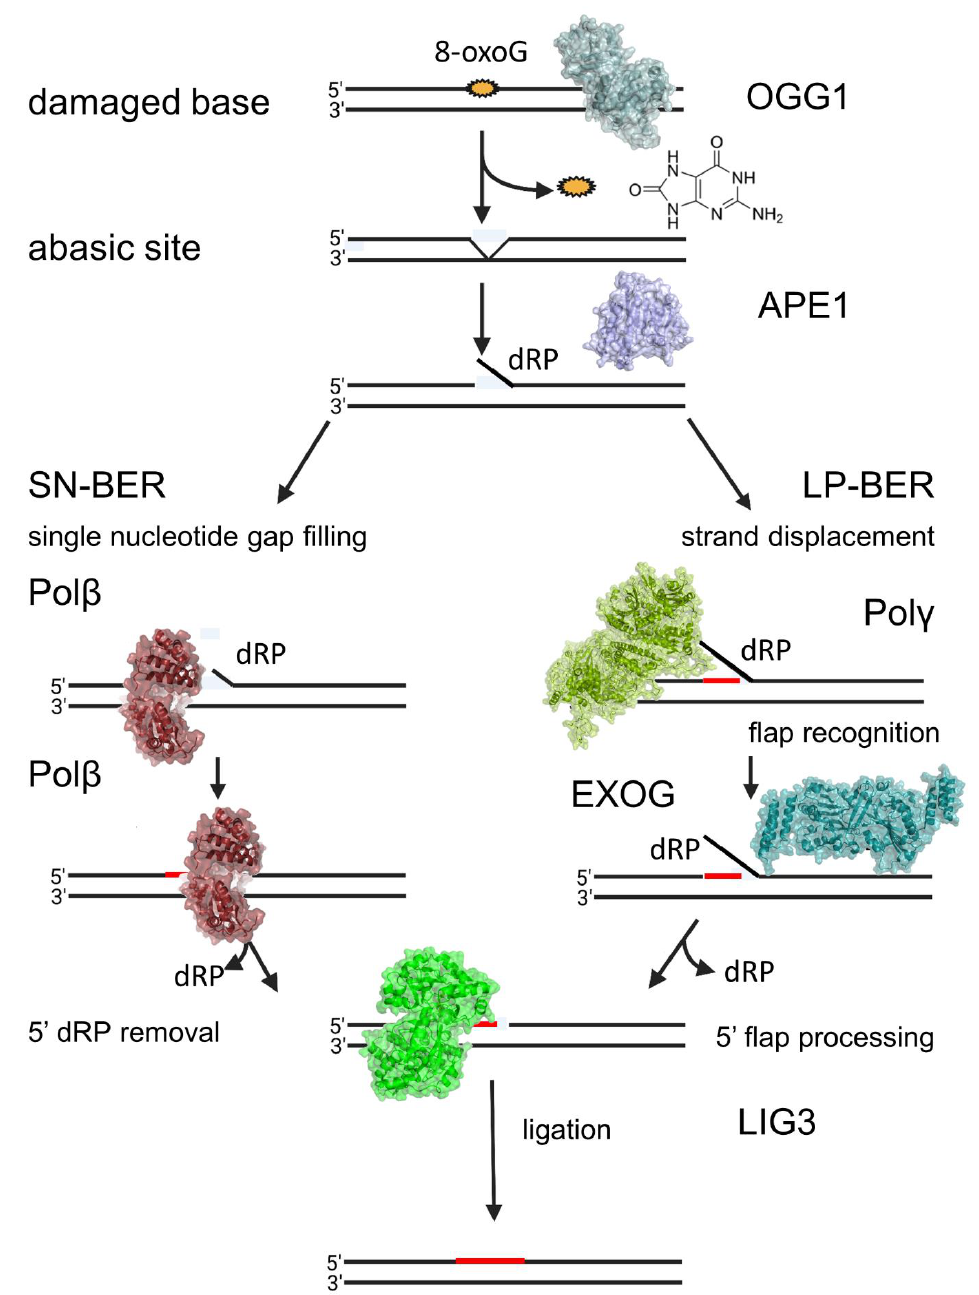
Figure 1. Mitochondrial base excision repair pathway. ROS damage in mtDNA leads to the produc- tion of the mutagenic 8-oxoguanine lesion, which is excised by 8-oxoguanine DNA glycosylase- 1 (OGG1), PDB code: 1EBM, generating an abasic site. This abasic site is then processed by apurinic/apyrimidinic nuclease 1 (APE1), PDB code: 5DFF, which creates a strand break 5 (cid:48) to the lesion. Repair of this strand break can proceed via either the single-nucleotide base excision repair (SN-BER) pathway (left) or the long patch base excision repair (LP-BER) pathway (right). In SN-BER, the nucleotide gap is filled by DNA Polymerase β (Pol β ), PDB code: 1BPZ, and the 5 (cid:48) dRP is removed by Pol β ’s dRP lyase activity. In LP-BER, DNA Polymerase γ (Pol γ ), PDB code: 5C53, displaces the flap and EXOG, PDB code: 5T40, recognizes and processes the flap. Pol γ is also responsible for incorporating new nucleotides in LP-BER. The final step of base excision repair involves ligation of the sugar-phosphate backbone by DNA ligase III (LIG3), PDB code: